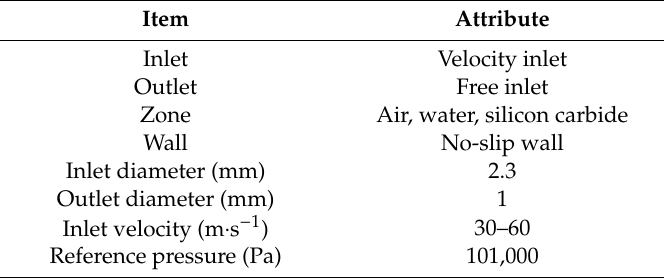
Figure 5. Two-dimensional mesh generation: 1. inlet, 2. wall, 3. outlet ( a ) global mesh and ( b ) local mesh. Table 4. The boundary conditions of the model.